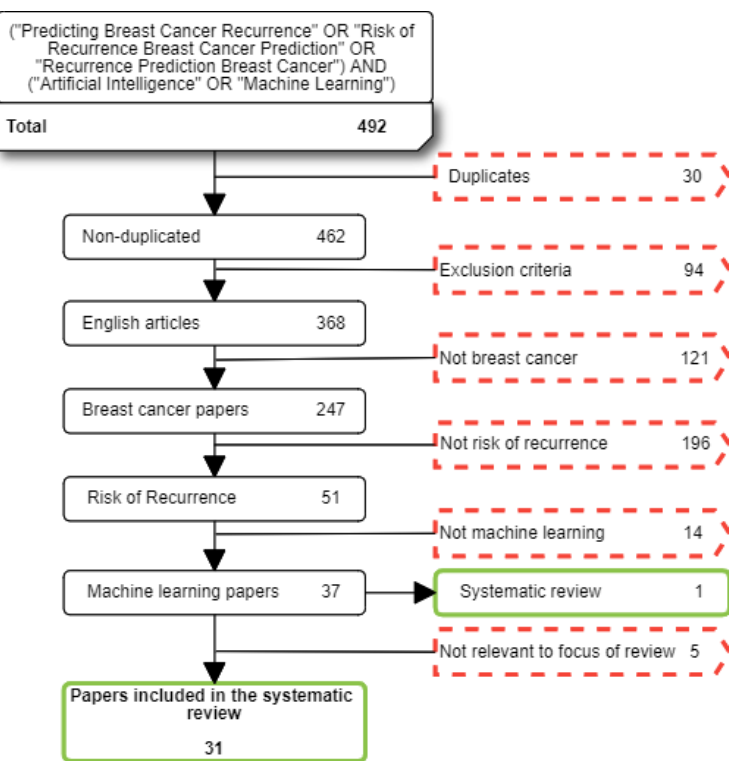
Figure 1. Flow diagram summarising the literature search, inclusion, and exclusion process. Red dotted squares correspond to excluded paper; green continuous squares correspond to selected